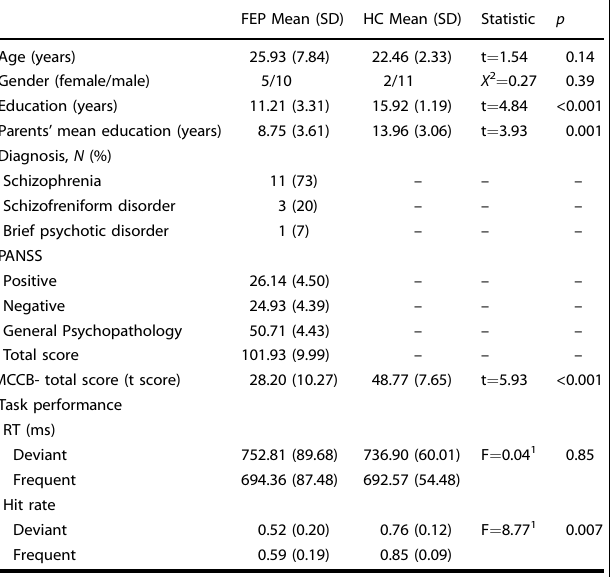
Table 1. Demographic, clinical, and behavioral variables.